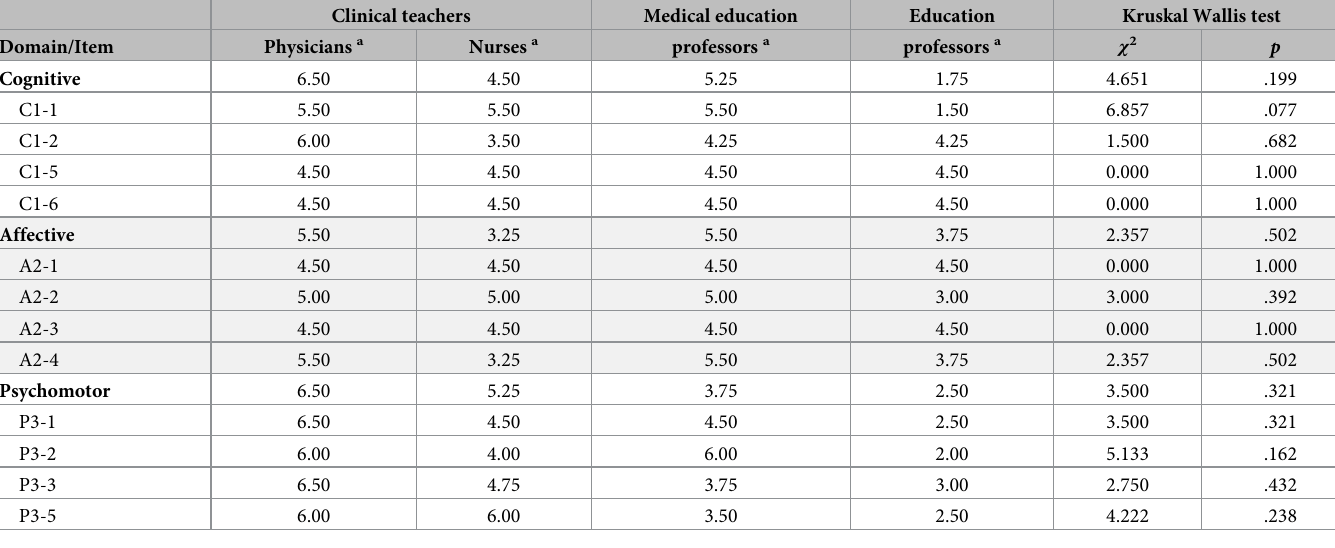
Table 2. Background differences in the L-SES (Kruskal—Wallis test).